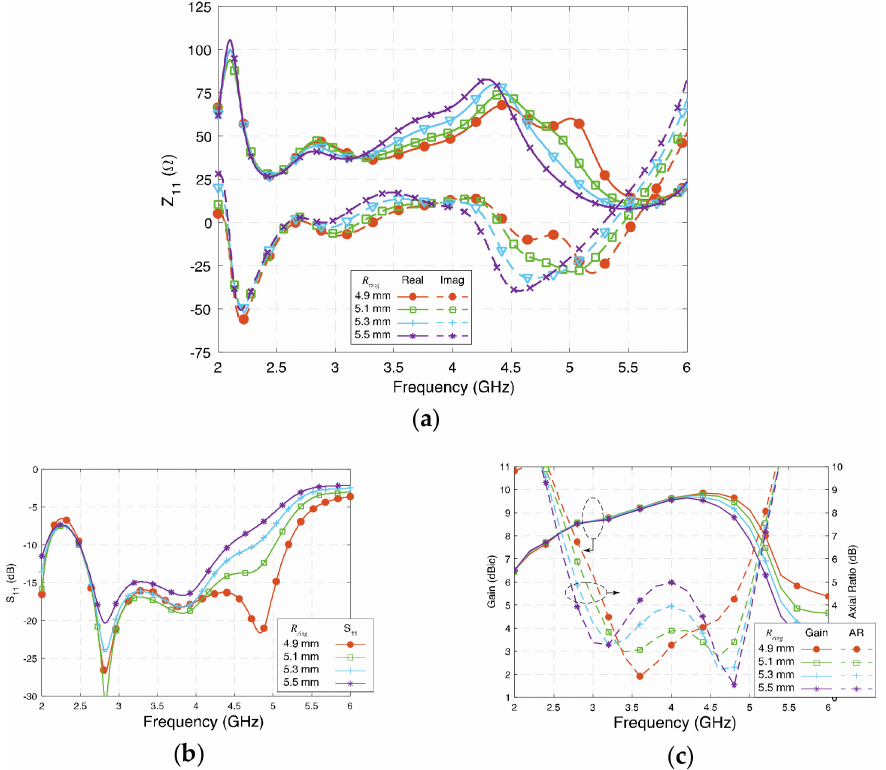
Figure 8. ( a ) Impedance (Z 11 ), ( b ) reflection coefficient (S 11 ), and ( c ) gain and axial ratio of the proposed antenna at different R ring